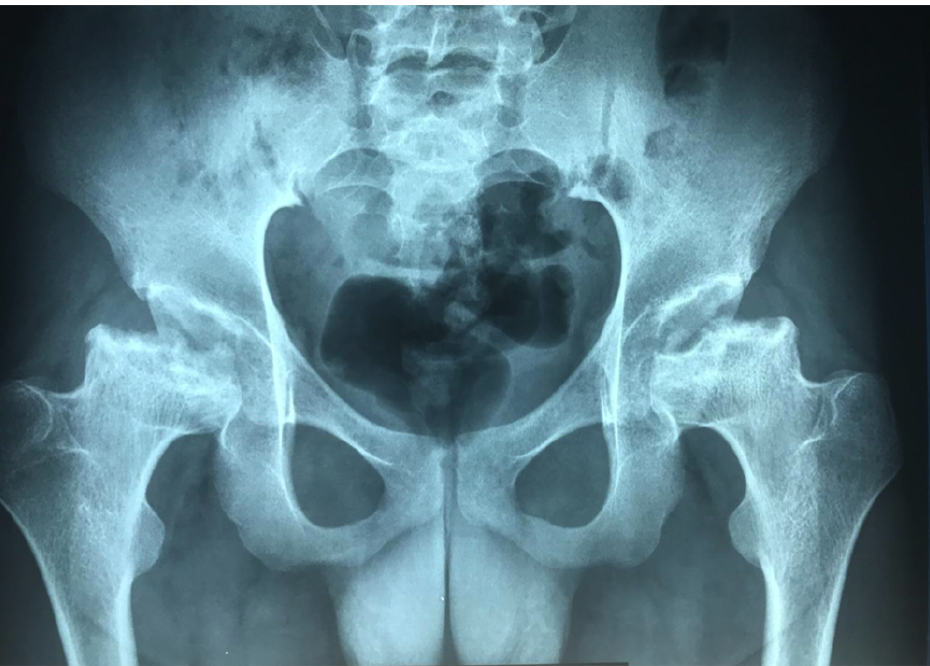
Figure 4. Hip radiography of a male 15-year-old MPS IVA patient (#patient 14) with acetabular dysplasia, subluxation of the femoral head associated with flattening and fragmentation, resembling femoral head avascular necrosis or Perthes